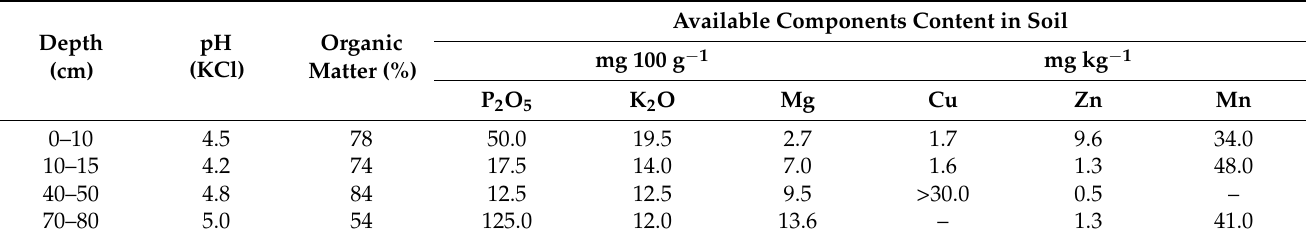
Table 2. Chemical characteristics of soils before establishment of experiment (2012).